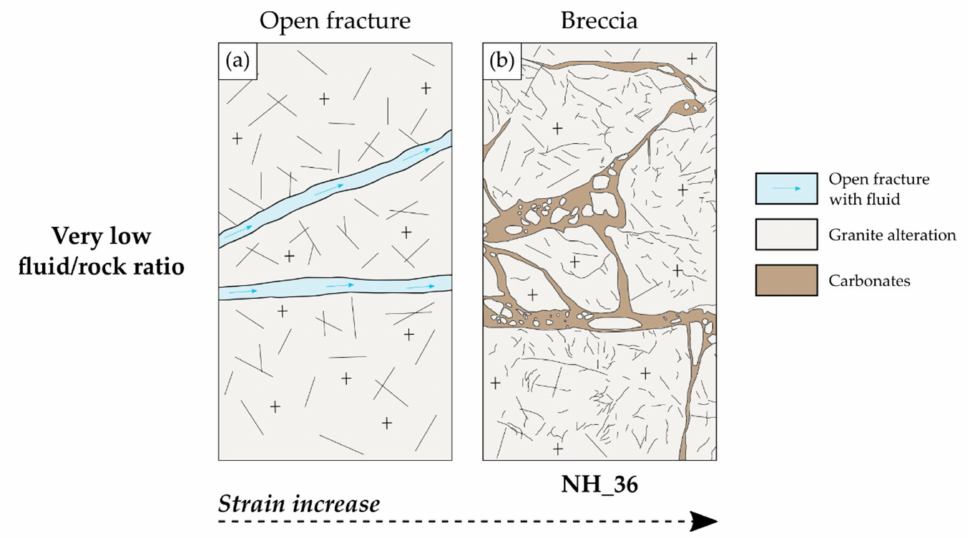
Figure 19. Synthetic scheme showing, from low to moderate strain, the interaction between the fluid and the granite in the cases of a very low fluid/rock ratio. ( a ) Open fractures with an incipient alteration of the surrounding rock. ( b ) Brecciated zones with a carbonated matrix and no change of alteration degree. No scale is given for this scheme, because it can represent fracture zones of several order of